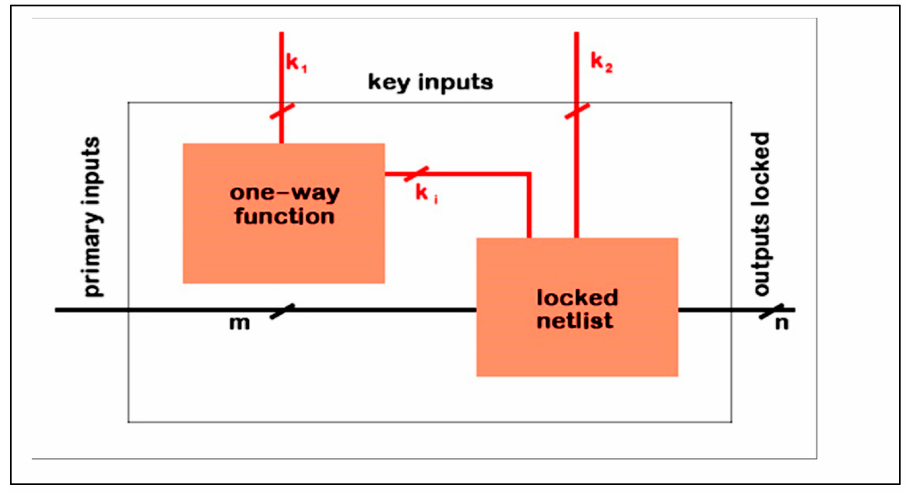
Figure 5. One-way function logic locks